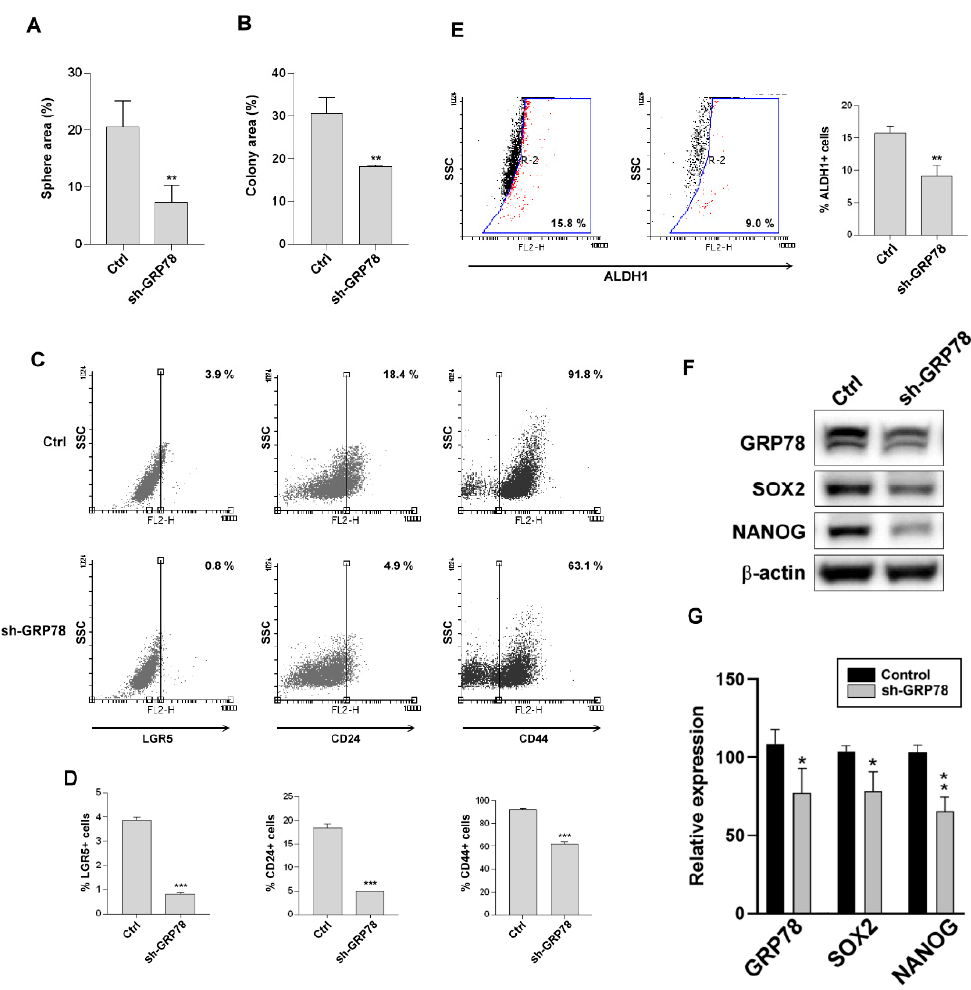
Figure 5. Glucose-regulated protein 78 (GRP78) silencing reduced the stemness capacity of MKN45 cells. ( A ) Representative pictures showing the spheroid-forming capacity between MKN45/ctrl and MKN45/sh-GRP78 cells. ( B ) Representative pictures showing the colony-forming capacity between MKN45/ctrl and MKN45/sh-GRP78 cells. ( C ) Expression of surface makers (LGR5, CD24, and CD44) was analyzed through flow cytometry in MKN45/ctrl and MKN45/sh-GRP78 cells. ( D ) Quantifica- tion of surface makers. ( E ) Aldehyde dehydrogenase 1-positive cells were analyzed through flow cytometry in MKN45/ctrl and MKN45/sh-GRP78 cells. ( F ) Protein expression of stemness-related transcription factors (SOX2 and Nanog) and GRP78 was analyzed through Western blot in MKN45/ctrl and MKN45/sh-GRP78 cells. ( G ) Quantification of the expression of stemness markers (SOX2 and Nano) and GRP78. Data are presented as the mean ± standard error of the mean; n ≥ 3 independent experiments, two-tailed Student’s t test: * p < 0.05, ** p < 0.01, *** p < 0.005.